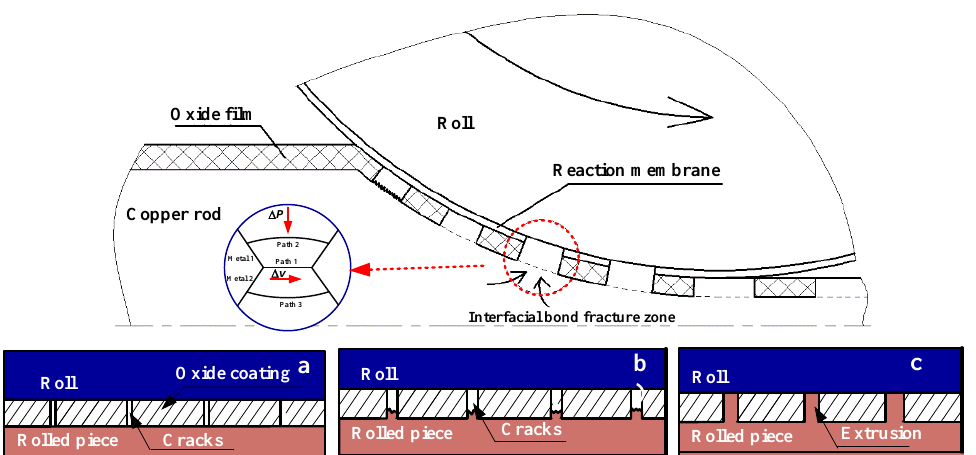
Figure 5. Schematic diagram of the mechanism of the roll sticking to the rolling copper rod. The main component of the copper rod is the Cu atom and, the internal binding energy is (Cu-Cu); the main component of the roll is the Fe atom and, the internal binding energy is (Fe-Fe), and the interface energy between the copper rod and the roll surface is (Fe-Cu). Research shows that the interface energy of Fe-Cu is greater than that of metal, and the internal binding energy of Cu-Cu is the minimum [32]. Therefore, the fracture point of welding occurs on the copper matrix with the minimum internal binding energy, which is characterized by the copper sticking phenomenon. At the same time, the temperature, friction stress, and normal pressure of the surface layer and sliding layer of the contact surface between the roll and the rolled piece during the hot rolling process—in addition to the degree of deformation—have an important influence on the adhesion behavior of copper